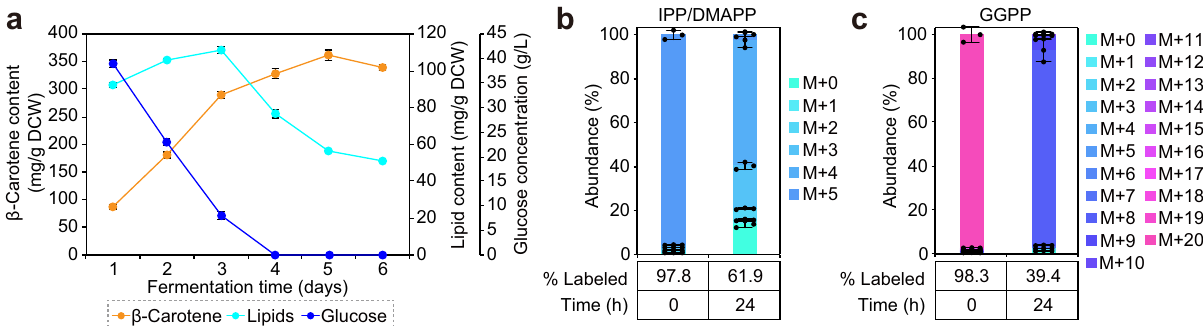
Fig. 5 Cellular lipids drive carotenoid biosynthesis through β -oxidation during stationary phase after glucose depletion. a Monitoring glucose concentration, lipid content, and β -carotene content throughout fermentation revealed that β -carotene continued to increase after glucose was exhausted from the media. On the other hand, intracellular lipids rapidly declined post glucose depletion, suggesting that cells were mobilizing TAGs as the alternative carbon source when glucose was no longer available. b , c Tracing carbons from cells cultured in [U- 13 C]glucose and natural abundance stearic acid indicated that β -oxidation can be a source for acetyl-CoA destined for carotenoid synthesis. The average and s.d. of three biologically independent experiments are shown. Source data are provided as a Source Data fi le.